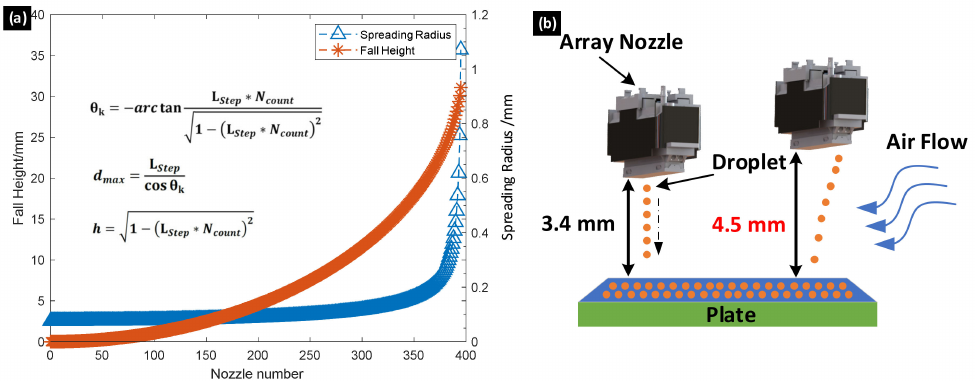
Figure 9. Di ff erence between the defect phenomenon measured by the profilometer and uniform printing. ( a ) Drawback measured by the step instrument. ( b ) Results generated in the case in which the droplets are uniformly fused.